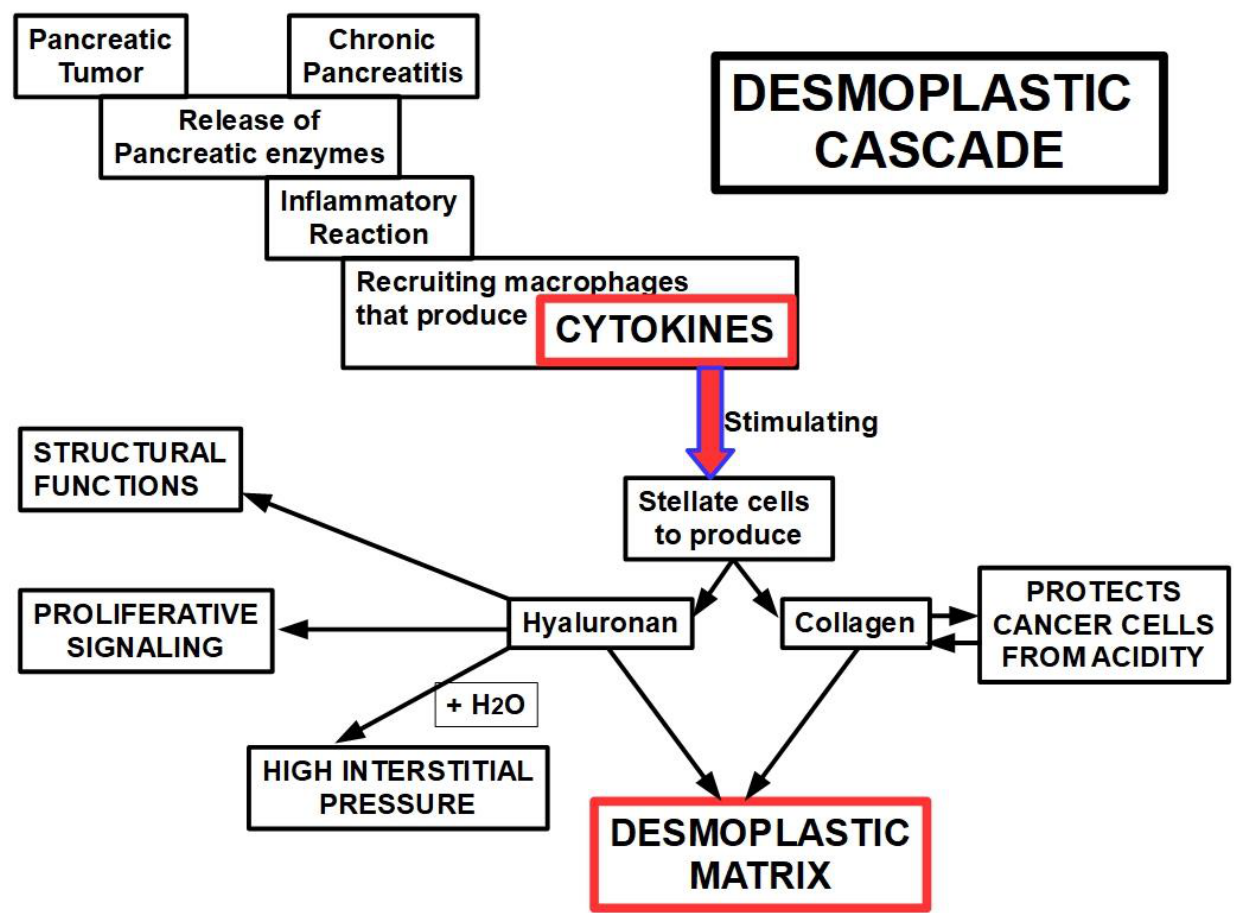
Figure 1. Diagram showing the possible mechanism leading to the desmoplastic reaction. It can betriggered by a pancreatic tumor or chronic pancreatitis. The physiopathology of the process seems similar in pancreatic cancer and chronic pancreatitis. Furthermore, non-active stellate cells can be activated through pancreatic injury, thereby becoming the multi-stellate cells that express alpha-smooth muscle actin (that is the reason they are considered myofibroblasts) [213]. The two issues described above, MDR proteins and desmoplastic stroma, are the core ofPDAC resistance to chemotherapy.